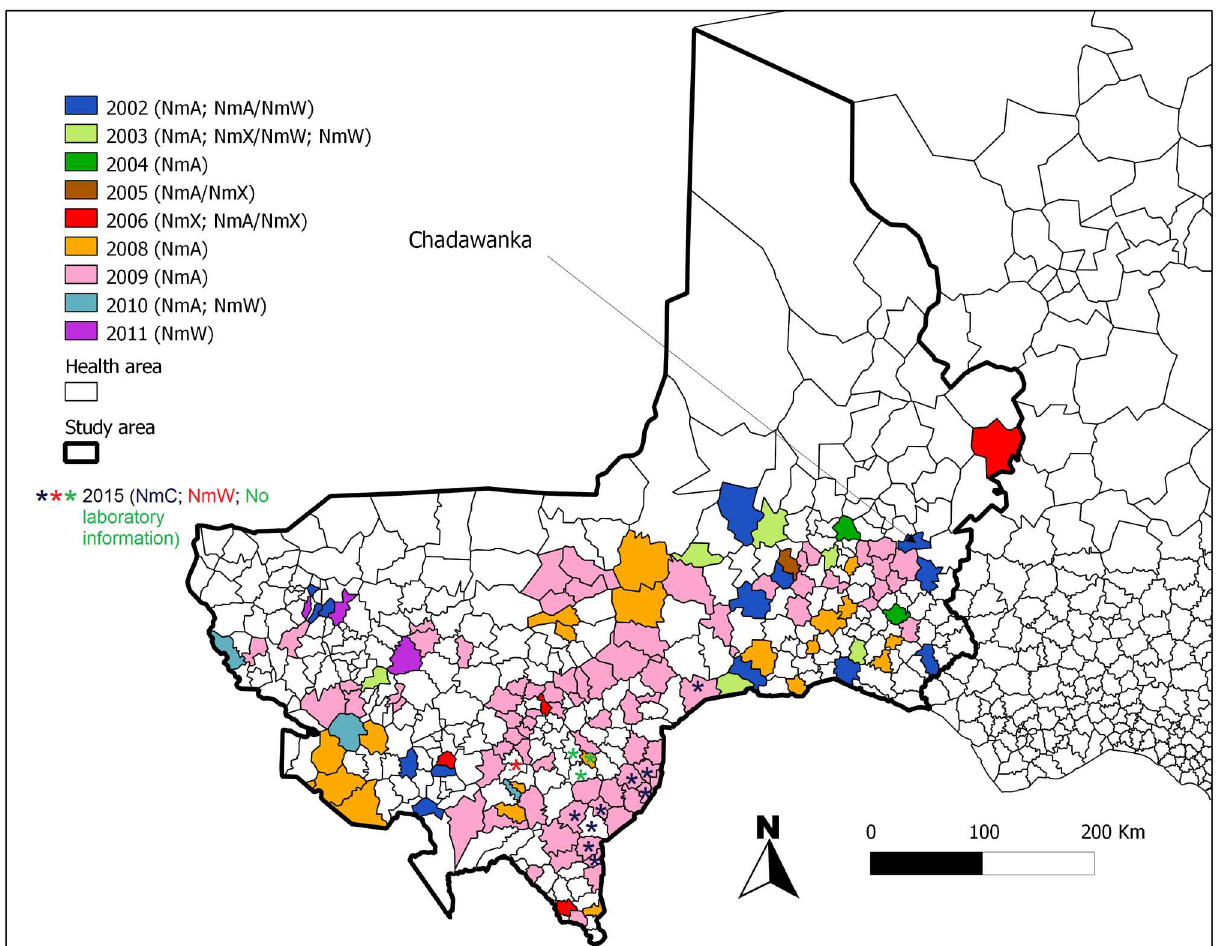
Fig 4. Spatial distribution and epidemic agent of the 175 meningitis localized epidemics in health areas of Tahoua, Tillabery and Dosso regions, Niger, 2002–2012 and 2014–2015. A localizedepidemicwas defined at the health area level as 20 suspected cases per 100,000during at least two consecutiveweeks (LE20). The health area of Chadawanka was the only HA which experienced four times a localizedepidemicin consecutive years 2002–2003 and 2005–2006. Epidemic agents were defined accordingto the majority of pathogens identifiedby systematic polymerasechain reaction testing on cerebrospinal fluid. The epidemiologicalyear n , from 1 st July of calendar year n-1 to 30 th June of calendar year n , is used here.